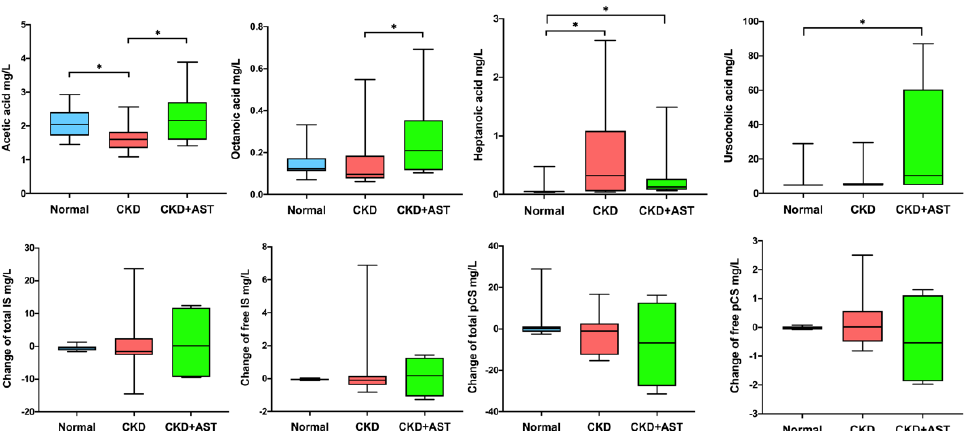
Figure 2. Changes in circulating metabolites concentrations associated with AST-120 treatment in advanced CKD patients. The box-plot reveals the median, the 25th, and the 75th percentile. Wilcoxon rank sum test was used to detect differences among groups. * p < 0.05. CKD, chronic kidney disease; IS, indoxyl sulfate; pCS, p cresyl-sulfate.